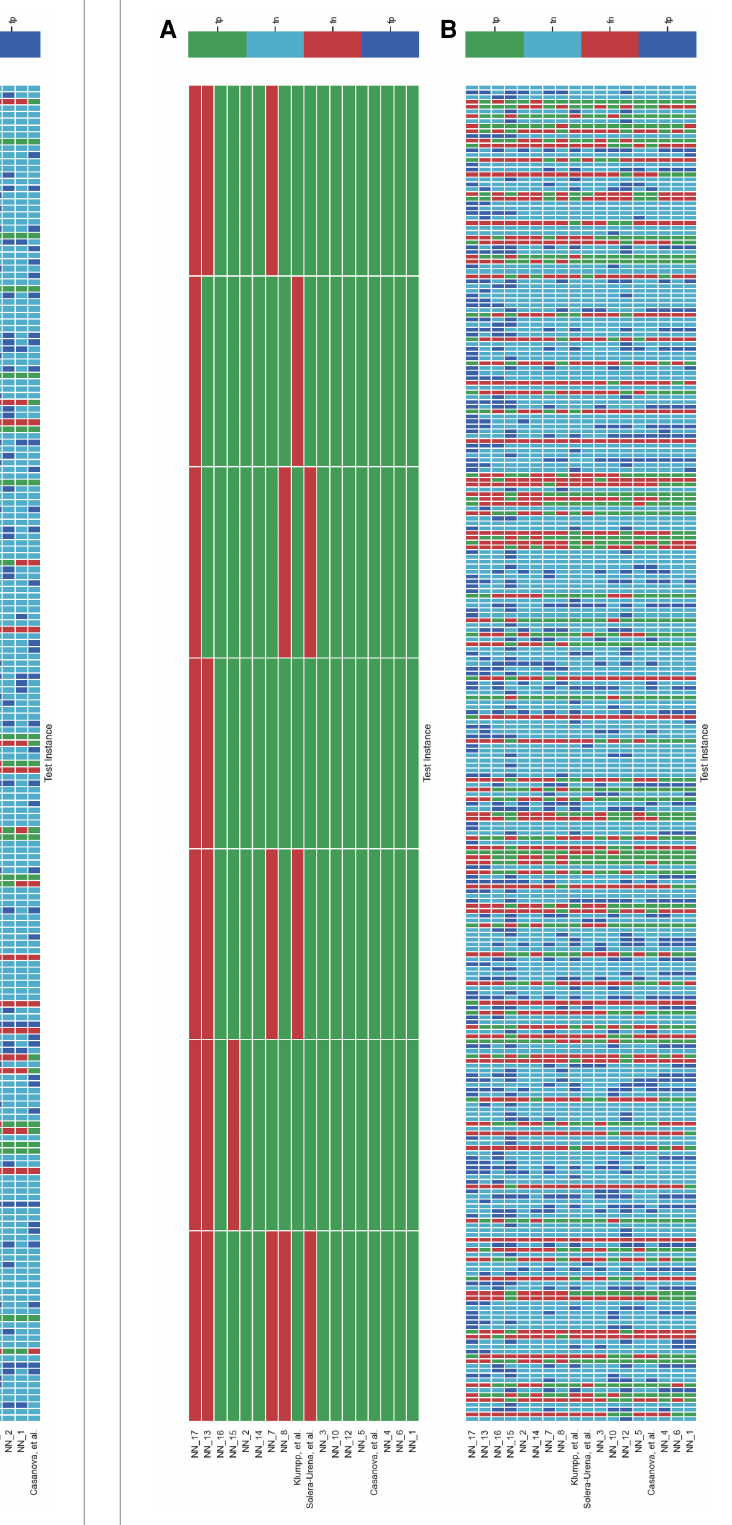
FIGURE A4 Schematic detailing the level of agreement as in Figure 5 with test instances with either a low sample rate (below 12kHz) ( A ) or high sample rate (above 12kHz) ( B ).